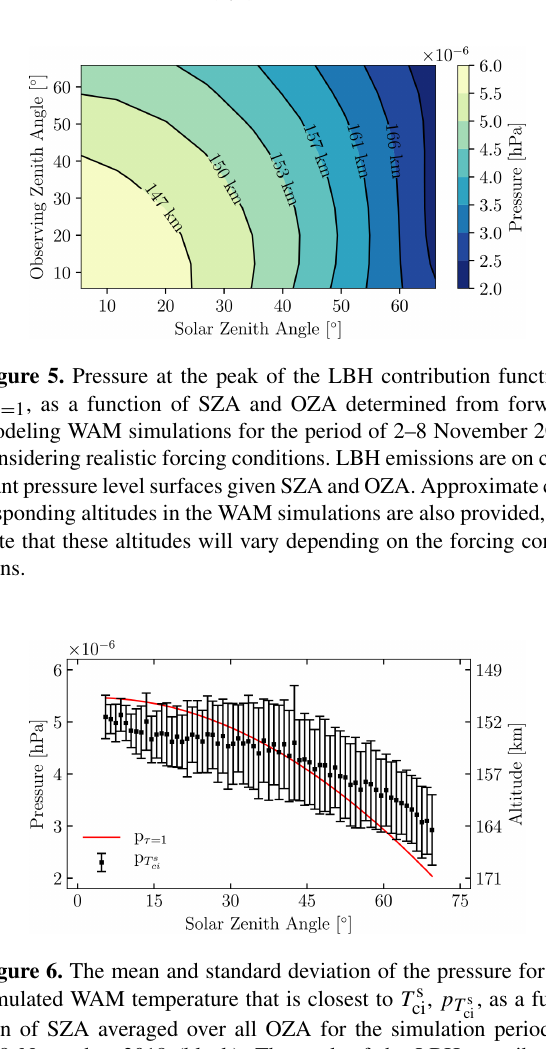
, p T s , as a func- ci ci